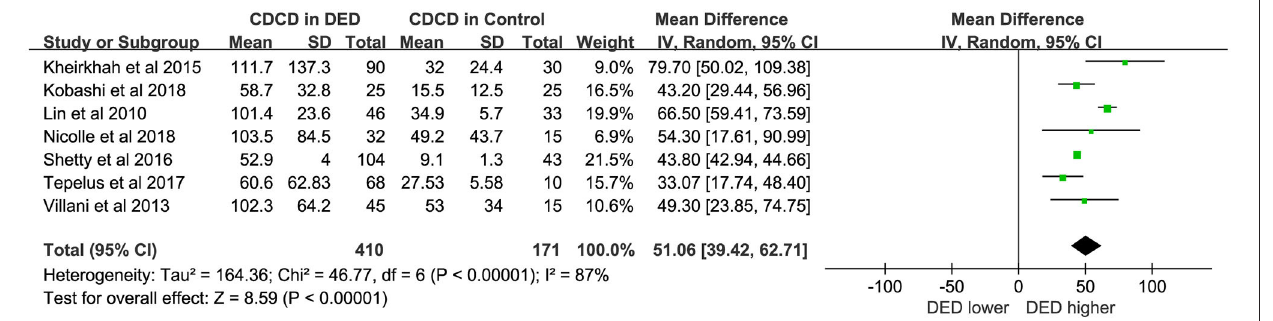
FIGURE 2 | Meta-analysis forest plot of central CDCD in DED patients vs. control group.